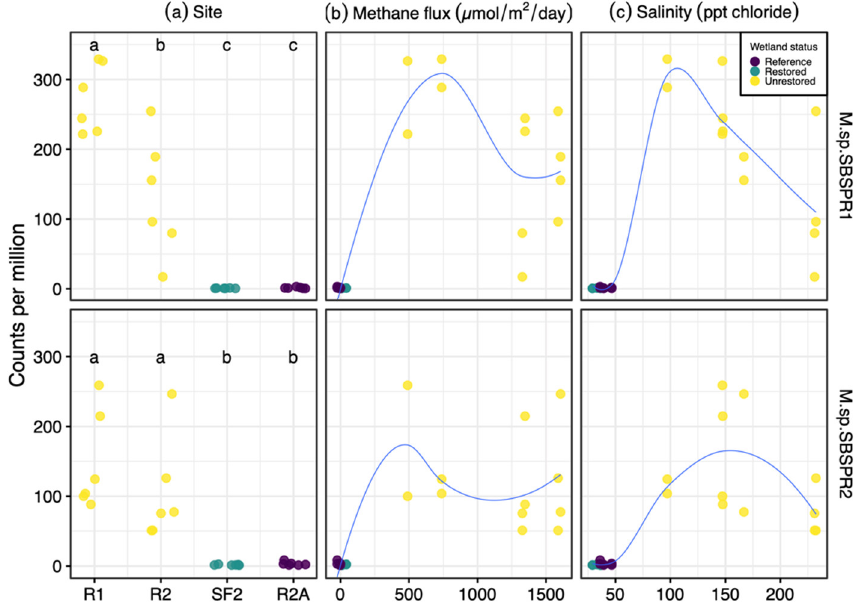
Figure 5. Abundance of Marivita sp. SBSPR1 and SBSPR2, expressed as counts per million assembled reads, across 24 metagenomic samples from Zhou et al. (2021) [15], organized by ( a ) site, ( b ) methane flux, and ( c ) salinity. Lines from loess functions are shown in ( b , c ). R1, R2, SF2, and R2A refer to site names as in Zhou et al. (2021). Different letters in ( a ) denote statistically significant pairwise differences (Nemenyi posthoc test, p < 0.05).